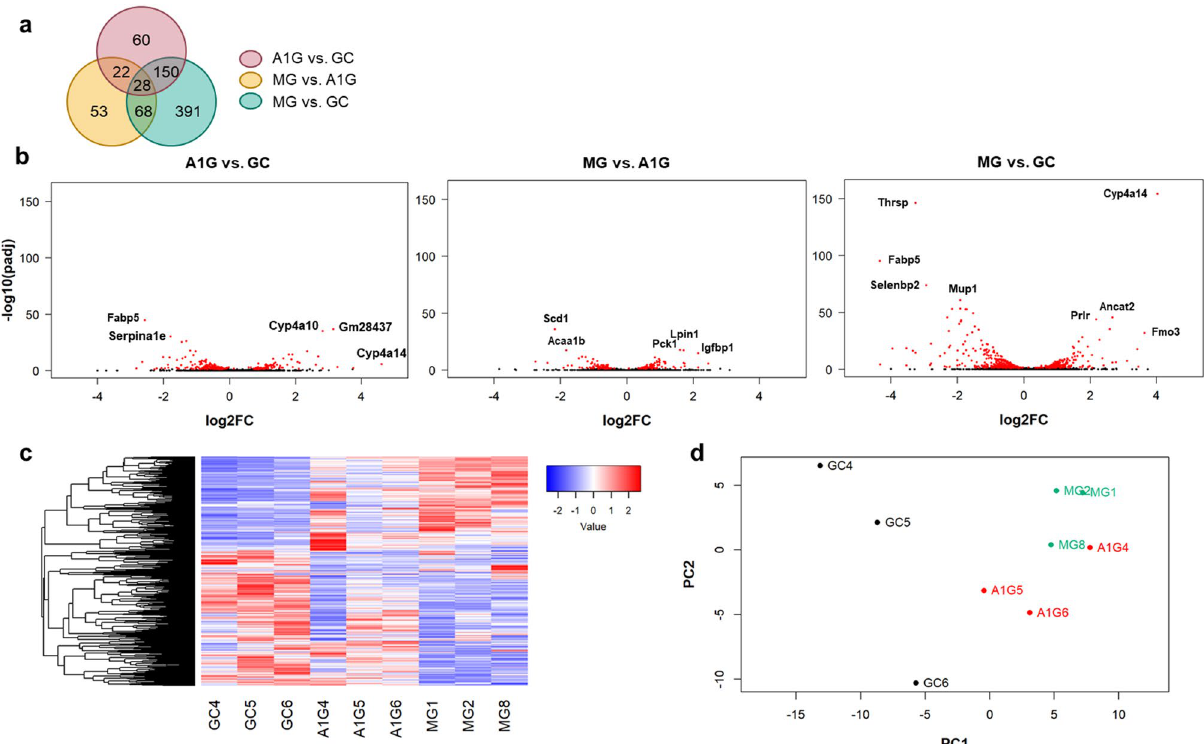
Figure 3.. Global transcriptomic differences in the livers from control mice on Earth (GC), mice under artificial earth gravity in space (A1G), and mice under microgravity in space (MG). ( a ) Venn diagram representing the number of significant differentially expressed genes. The number of overlapping regions means significant differentially expressed genes in common. For example, the number of overlapping regions of “A1G vs. GC” and “MG vs. GC” was 150, indicating that 150 genes were significantly differentially expressed between not only A1G and GC, but also MG and GC. ( b ) Volcano plot showing the log2 scaled fold change (x-axis) and the minus log10 p -value (y-axis) of each gene in the differential expression analysis. Genes with a significant expression change are highlighted as red dots. Prominent transcripts are labelled by GeneSymbol. ( c ) Heatmap showing the gene expression values (normalized as transcripts per millions) of selected genes in each sample, significantly differentially expressed between any two groups. Red and blue color intensity correlates with relative signal abundance of selected genes. ( d ) Principal component analysis (PCA) plot, which shows the two first PCs (principal components) values of each sample. Differentially expressed genes were detected by means of DESeq2 37 cloud using a Wald test, a parametric fit type, and setting an adjusted p -value cutoff of 0.05 ( n = 3 each). Analysis was conducted in R 31